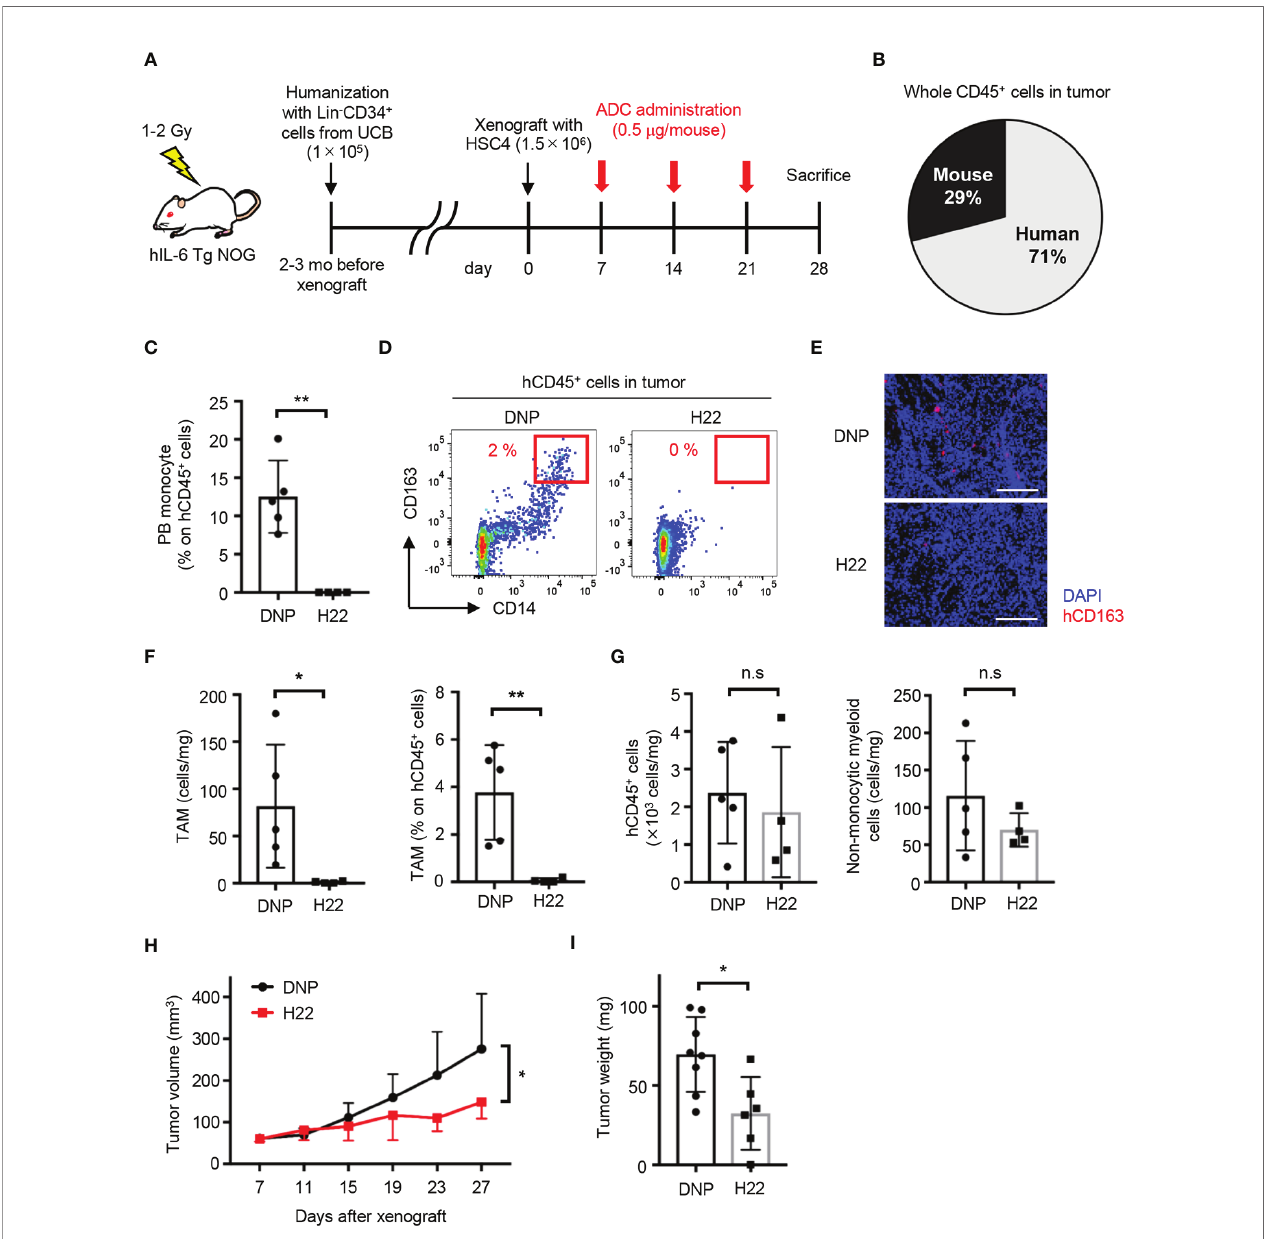
FIGURE 6 | H22-dPBD eliminates TAMs and inhibits the development of solid tumors. (A) Experimental scheme of the generation and therapeutic treatment of solid tumor-bearing humanized mice with ADCs. At day 0, HSC4 cells (1.5×10 6 cells/mouse) were subcutaneously transplanted in hIL-6 Tg NOG mice humanized with UCB-derived Lin - CD34 + cells. DNP- or H22-dPBD (0.5 µg/mouse) were intravenously injected to the mice once a week from day 7 and tumor sizes were measured every 4 days from day 7. The mice were sacri fi ced at day 28 and tumor weights and cells in fi ltrating the tumors were evaluated. mo: months. (B) Ratio of hCD45 + and mCD45 + cells in total leukocytes in the tumor. (C) Frequency of monocytes in circulating hCD45 + cells at day 28. (D) Representative FCM plots of tumor- in fi ltrating hCD45 + cells. Frequencies of CD163 hi CD14 + TAM-like cells are shown. (E) Histological evaluation of tumor-in fi ltrating CD163 + cells in DNP-dPBD- or H22- dPBD-treated mice. Scale bars: 200 m m. (F) Number and frequency of TAMs in DNP-dPBD- or H22-dPBD-treated mice. (G) Numbers of total hCD45 + cells and hCD45 + CD3 - CD19 - CD56 - CD14 - (non-lymphoid, non-monocytic) cells in the tumor. (H) Time-course analysis of tumor development. Tumor volumes were calculated according to the following formula; 0.5 × length × (width) 2 . Statistical analysis was performed on data at day 27. Averages of tumor size in each group were shown. (I) Tumor weights of DNP-dPBD- or H22-dPBD-treated mice at day 28. Error bars represent standard deviation of the mean. Each point in the bar graphs shows the value for an individual mouse (DNP-treated group: n=8, H22-treated group: n=6). Student ’ s t -test was performed to assess statistical signi fi cance. * p < 0.05, ** p < 0.01; n.s, not signi fi cant. Data are representative of three independent experiments (D, E) or are pooled from two independent experiments (B, C, F – I) . Data points more than two standard deviations from the mean were excluded as outliers (H, I)